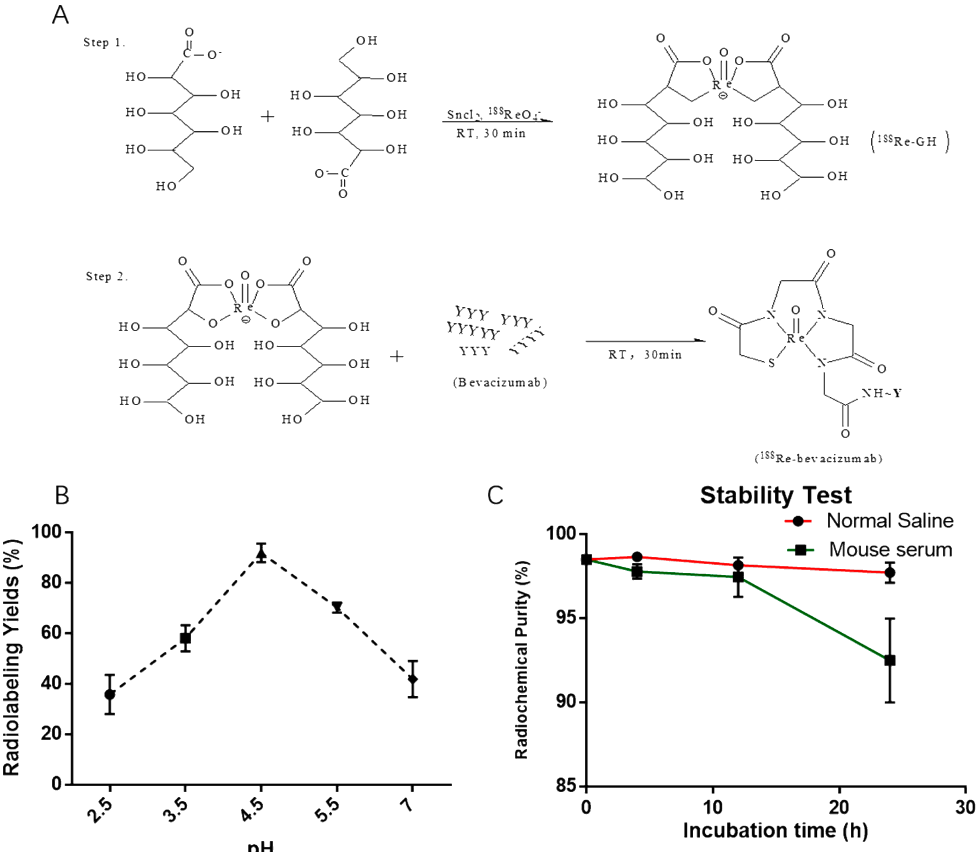
Figure 1. ( A ) Synthesis of 188 Re-bevacizumab by a two-step reaction; ( B ) Effects of pH on complexation yield of 188 Re-bevacizumab; ( C ) Stability of 188 Re-bevacizumab incubated with normal saline (pH 7.4) and mouse serum in vitro at room temperature was measured at various times.